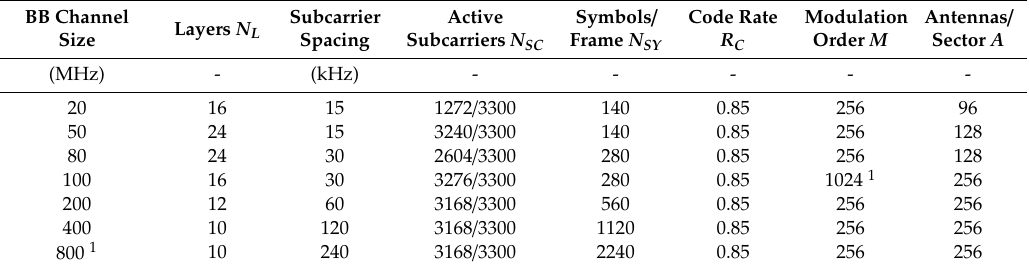
Table 1. Main parameters of NR-PHY Rel-15 interface and radio-antenna modules needed to calculate FH / MH link bandwidth consumption [2,29,51].